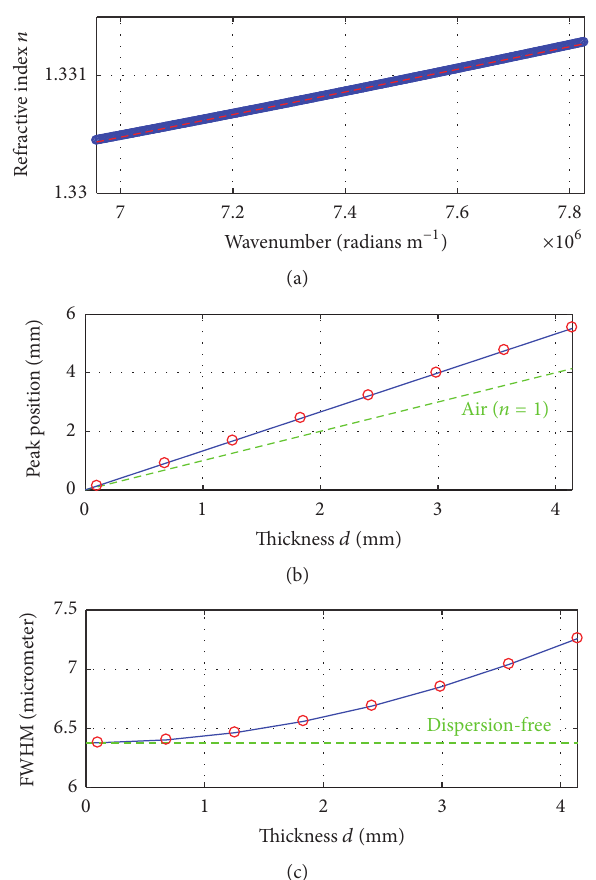
Figure 4: (a) Refractive index of water versus wavenumber (blue line) and linear fit (dashed red line). (b) OCT peak position versus thickness of water (red circles) and theory (blue line). Also indicated isthedisplacementinair(greendashedline).(c)FWHMpeakwidth of the OCT signal versus water thickness (red circles) and theory (blue line). Also indicated is the dispersion-free FWHM peak width (green line).